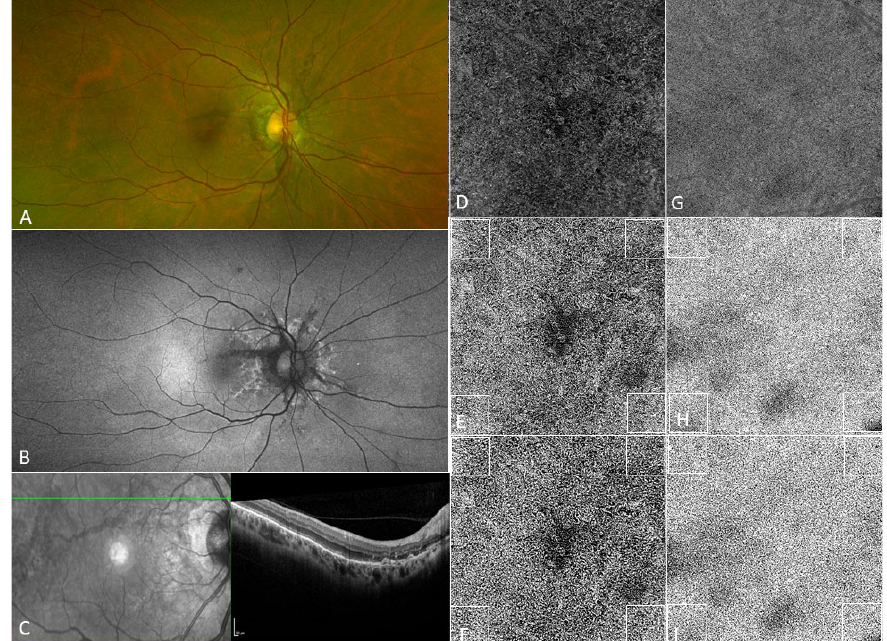
Figure 2. Quantitative analysis of the choriocapillaris and multimodal imaging of a 55 year-old patient presenting with angioid streaks. ( A ): Ultra-wide field color fundus photography revealing the presence of grey peripapillary jagged break lines. ( B ): Ultra-wide field autofluorescence fundus photography in the same patient showing hypo- and hyperautofluorescent break lines radiating from the optic disc. ( C ): Spectral domain optical coherence tomography in the same patient showing peripapillary atrophy. ( D ): Choriocapillaris en face flow image of the patient in panels A–C, as well as the resulting image after image processing using the Phansalkar local thresholding method with a window radius of four pixels ( E ) and eight pixels ( F ). Of note, the right panel shows the images of a 57 ‐ year ‐ old healthy control choriocapillaris en face ( G ) flow image as well as the resulting image after image processing using the Phansalkar local thresholding method with a window radius of four pixels ( H ) and eight pixels ( I ). Table 1. Choriocapillaris quantitative study of the peripheral 1 × 1 mm squares applying the Phansalkar local thresholding method: comparisons between angioid streaks eyes and control eyes. Angioid Streaks Eyes ( n = 27)